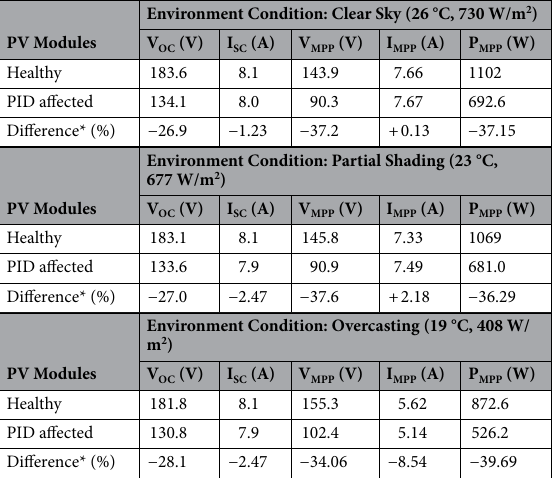
Table 2. Electrical parameters of the tested PV modules. *The “difference” is calculated as the following: PIDelectricalparameter × 100 100 − (cid:31) (cid:30) (cid:29)(cid:28) . The negative sign explains how much loss in the relevant electrical Healthyelectricalparameter parameter is induced due to the presence of PID.